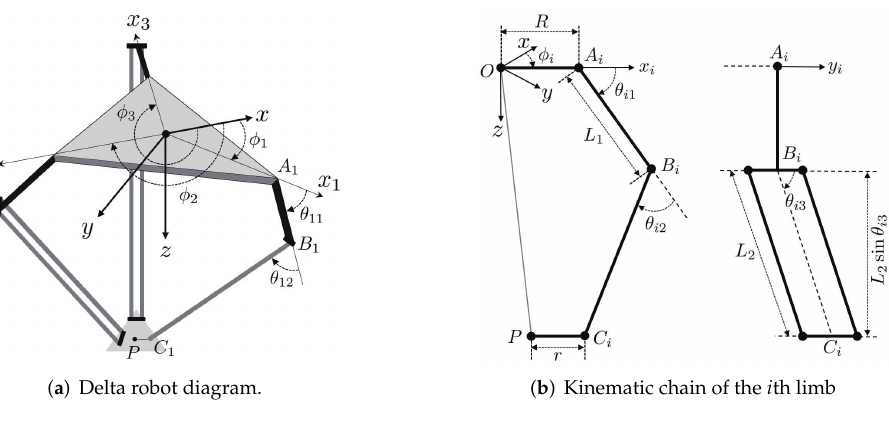
Figure 1. High-speed pick-and-place parallel-link robot designed at NT Robot, Co.